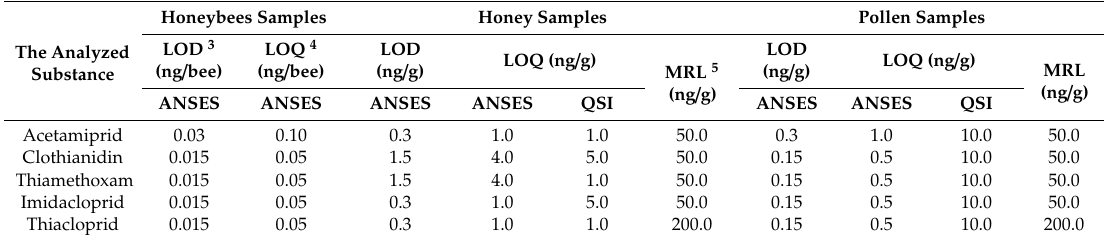
Table 3. The limit of detection and quantification of the involved laboratories, as well as the maximum residue limit in conformity with European legislation.